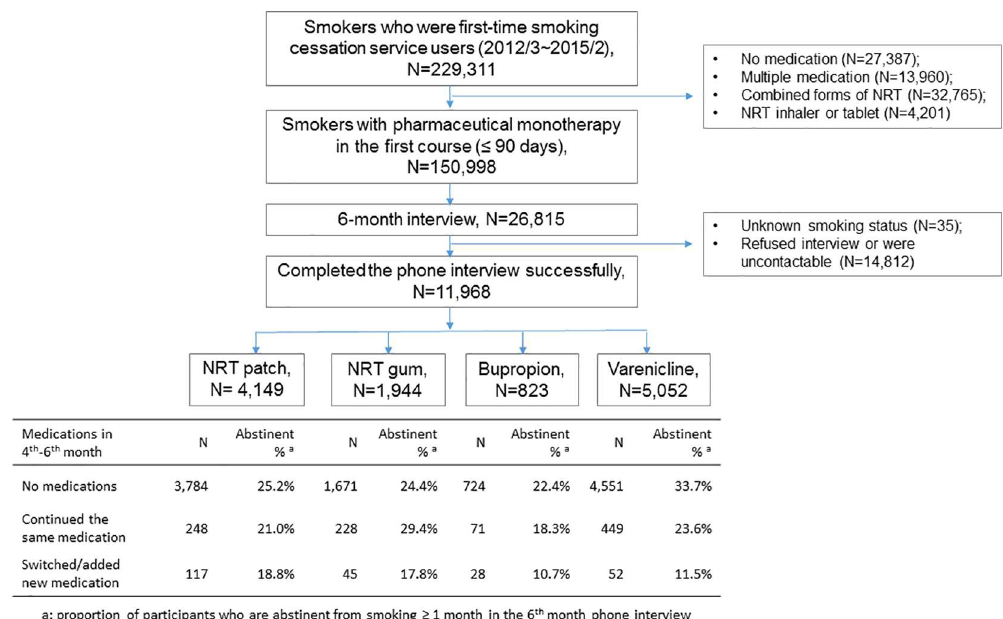
Fig 1. Participant selection and abstinence outcomes. NRT, nicotine replacement